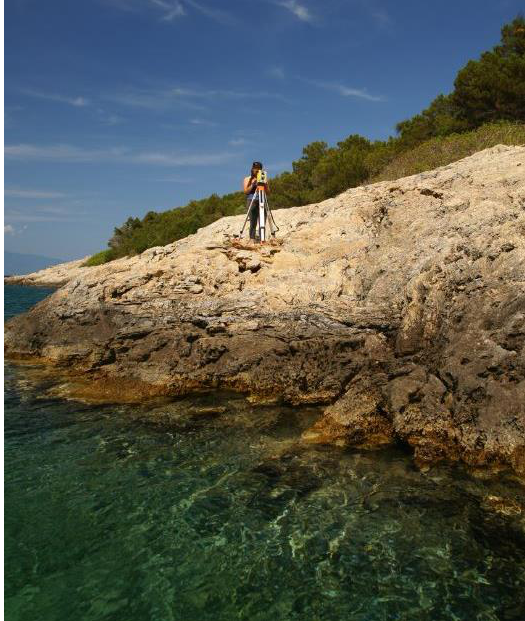
Figure 3: Land surveying at the rocky seashore of Cape Glaros (©H.I.M.A. 2015)